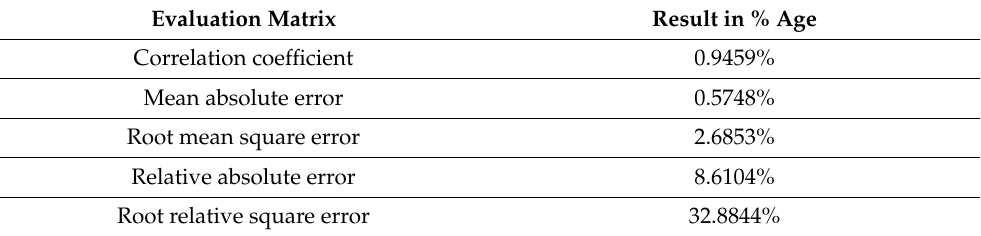
Table 6. Performance of CNN regression for the vertical eye gaze.